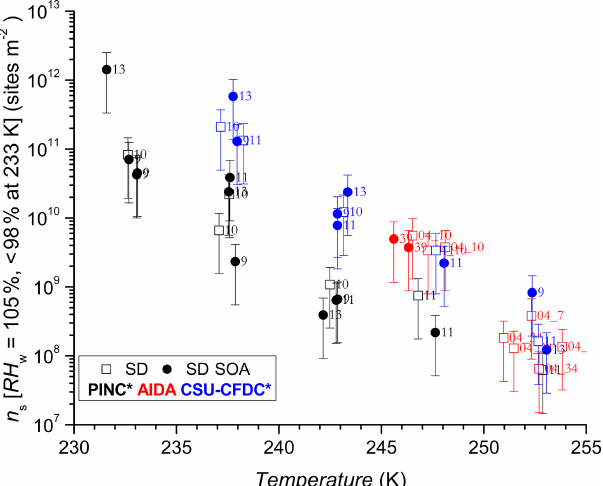
Figure 8. Same as Fig. 7 but for Saharan dust (SD) and SD coated with SOA (SD SOA)